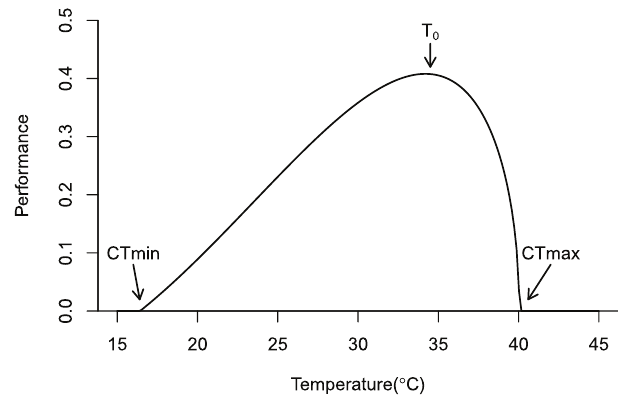
Figure 1. A thermal performance curve for a hypothetical ectotherm. All species, whether free-living or parasitic, rise and fall with temperature. Performance rises slowly from the critical thermal minimum (CTmin) to a thermal optimum (To), declining sharply to the critical thermal maximum